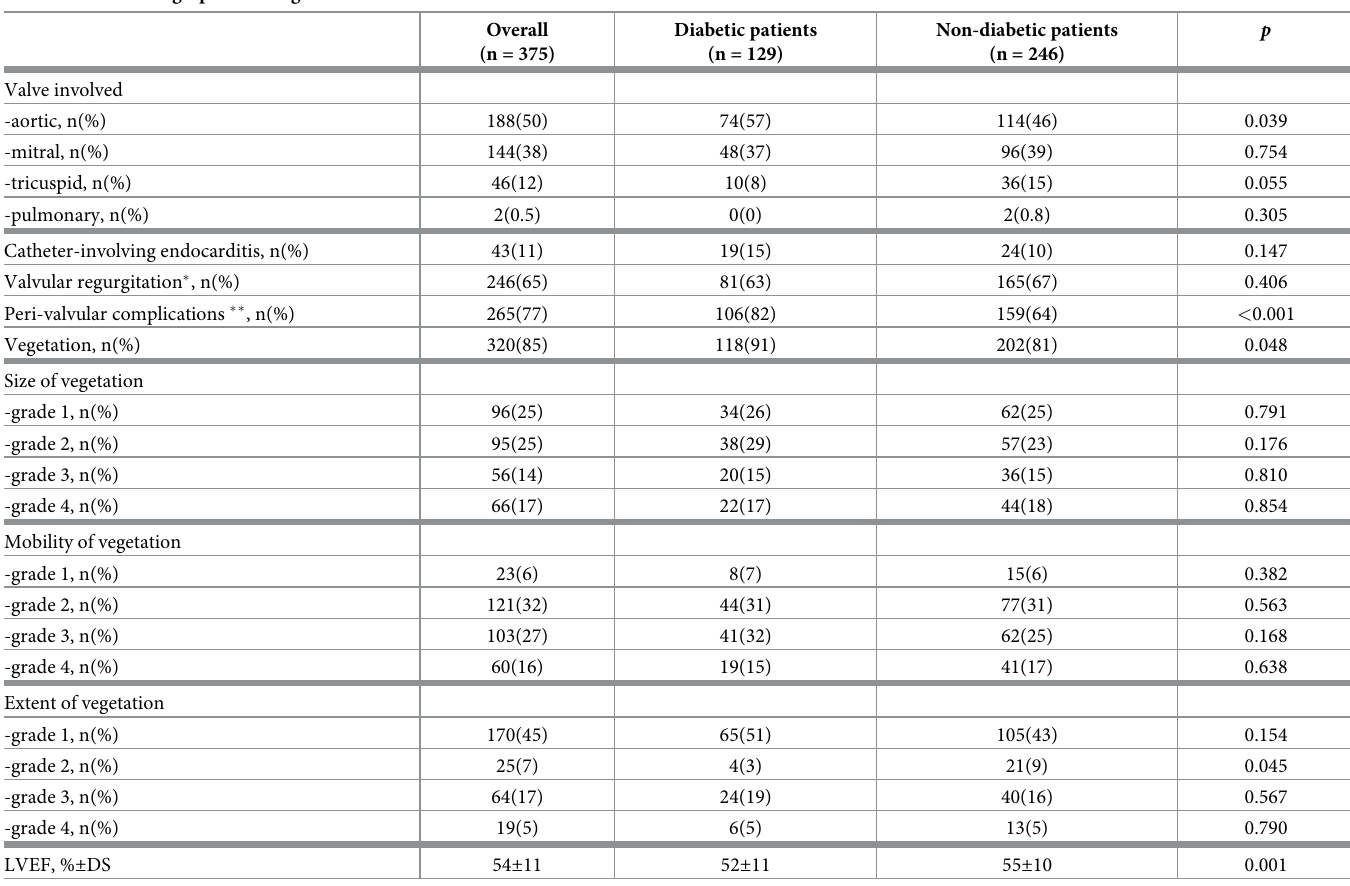
Table 3. Echocardiographic